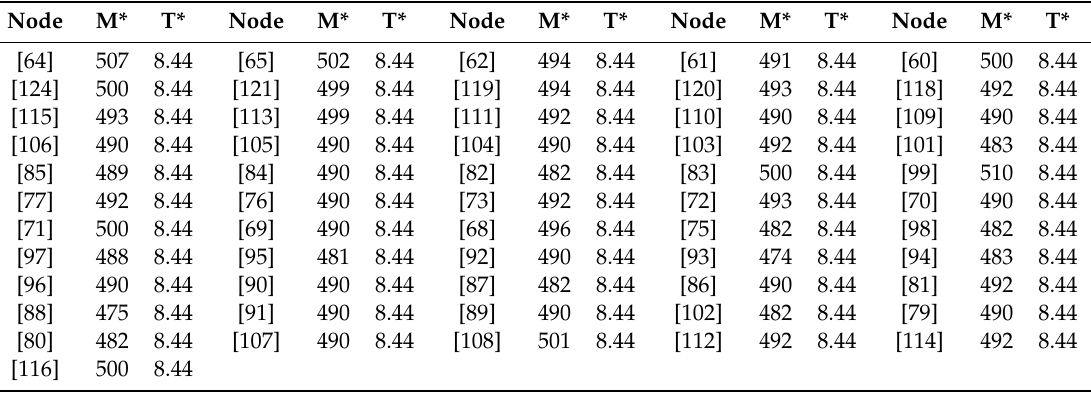
Table 7. The modified optimal maximum inventory level and optimal common review interval of all retail stores located in Route 1 based on PRIRPSDR.